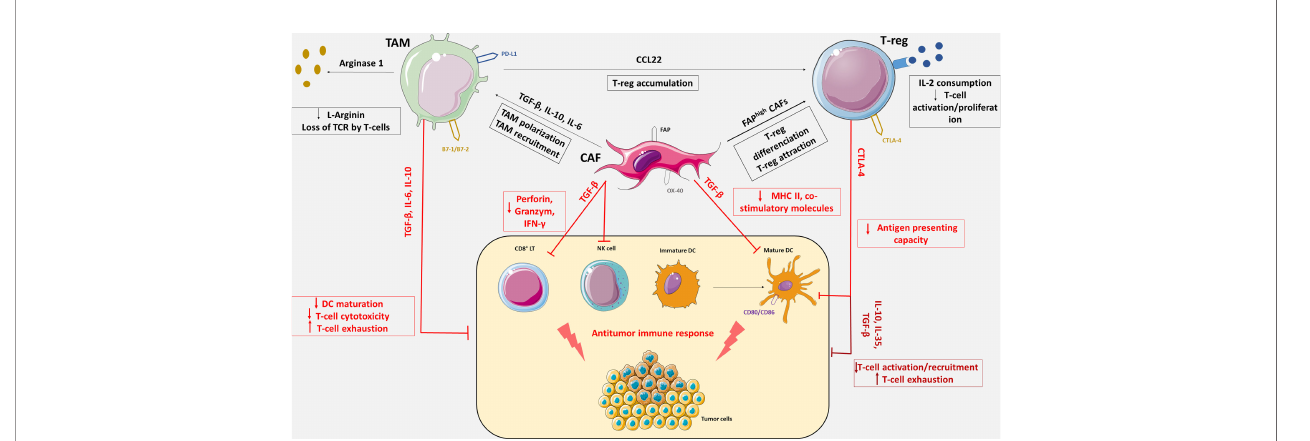
FIGURE 1 | Immunosuppressive tumor microenvironment mediated by Tregs, CAFs and TAMs. OC tumor microenvironment includes antitumor immune cells such as cytotoxic CD8 + T lymphocytes (CD8 + LT), natural killer cells (NK cells) and dendritic cells (DC), and immune tolerant cells such as tumor associated macrophages, cancer associated fi broblasts and regulatory T cells responsible for immune escape. TAMs, CAFs and Tregs express an array of effector molecules that inhibit the antitumor immune responses including cell surface receptors, cytokines, chemokines, and enzymes. Through the expression of immunosuppressive cytokines including TGF- b , IL-6, IL-10 and IL-35, TAMs, CAFs and Tregs inhibit CD8 + LT recruitment, activation and cytotoxicity, promote CD8 ⁺ LT exhaustion and impede DC maturation. CAFs also reduce antigen presentation function of DC via the secretion of TGF- b , which downregulate the expression of MHC II and co-stimulatory molecules on DC. CAFs can secrete IL-6 and thereby contribute to monocytes recruitment and macrophages differentiation to M2-like phenotype. TGF- b expression by CAFs negatively regulate NK cells activation and cytotoxic activity. FAP high CAFs increase differentiation of CD4 ⁺ cells into CD25 + FoxP3 + Tregs and retain them at their surface by expression of OX-40. Tregs constitutively express the co-inhibitory molecule, CTLA-4 which inhibits antigen presentation by binding on CD80 and CD86, co-stimulatory molecules expresses on DC. Tregs also inhibit CD8+ LT activation via IL-2 consumption which is necessary to T-cells activation. The cytokine CCL22 produces by TAMs generate chemokine gradient that induces Treg accumulation in the TME. TAMs also express co-inhibitory molecules such as PD-L1 or B7-1/B7-2 and suppress CD8 + LT cytotoxic activity upon activation with their ligand, PD-1 and CTLA-4. TAMs also impair LT activity though metabolization of L- Arginine which is essential for T-cell function and TCR